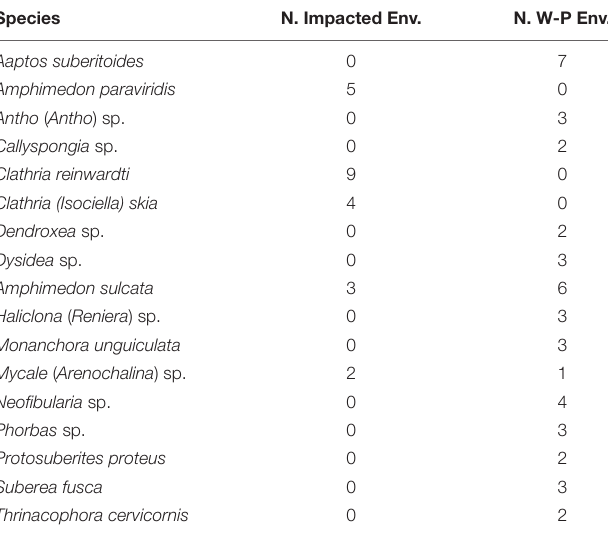
TABLE 1 | Species replicates used for the microbiome study. Species N. Impacted